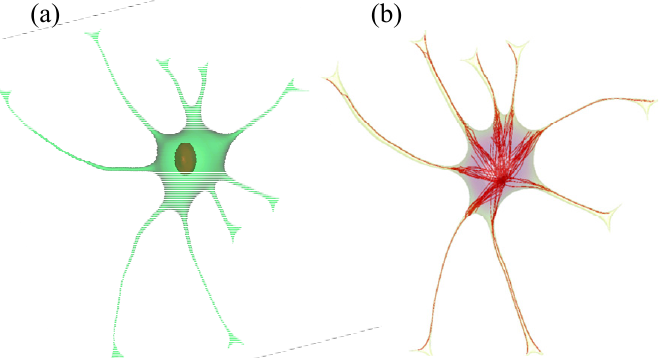
Figure 2. Implementation of nucleus ( a ) and microtubules ( b ) into the reconstructed 3d cell